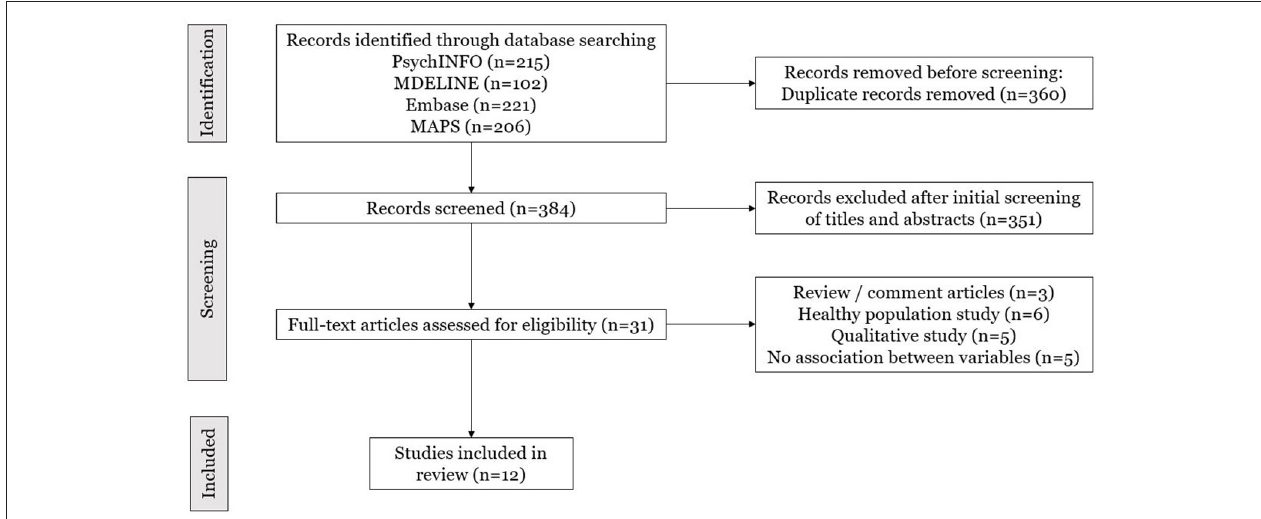
FIGURE 1 | Consort flow